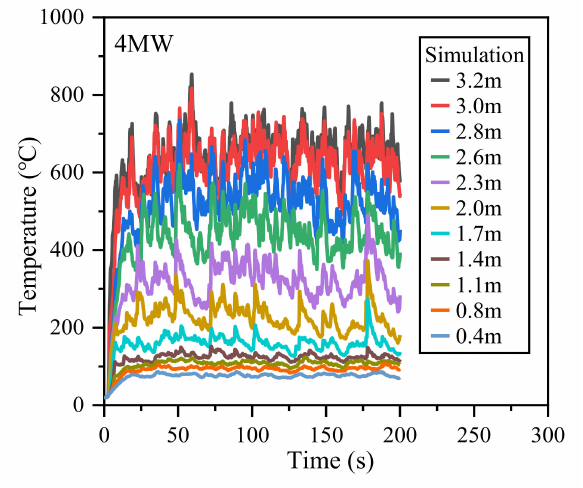
Figure 21. Window edge temperature under window sprinkler conditions.